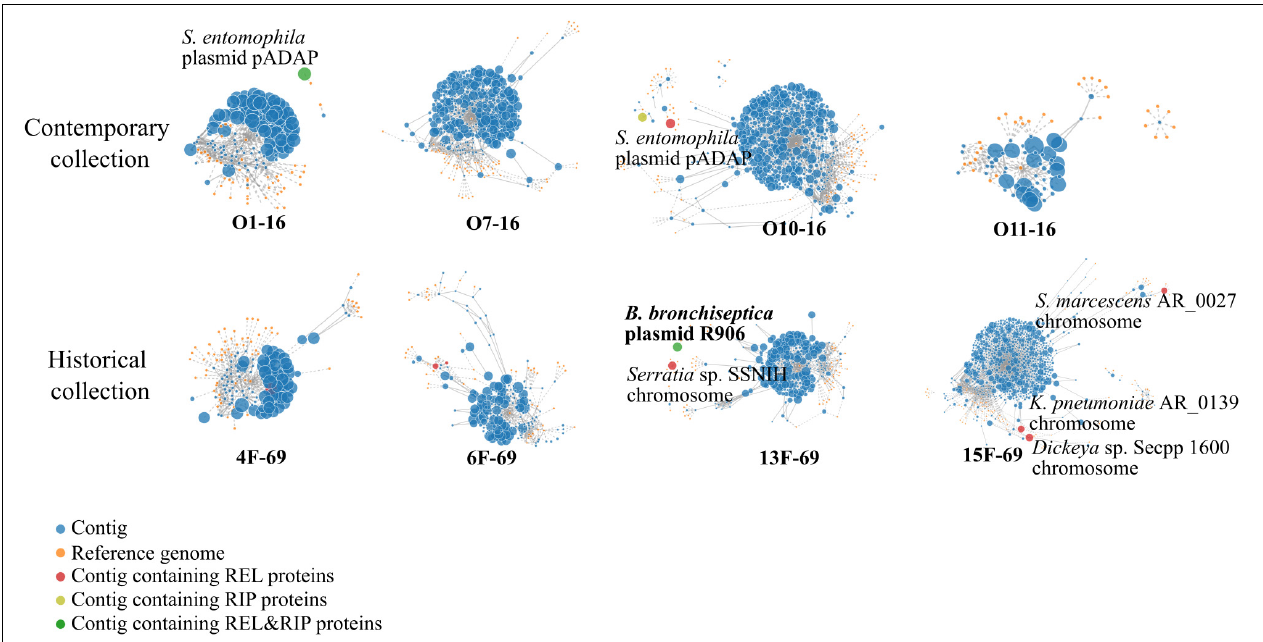
FIGURE 4 | PlacnetW output reflecting the plasmid sequences detected. All contigs from each genome are represented as blue nodes connected by continued lines. Yellow nodes represent reference genomes from the NCBI BLAST database. Discontinued lines link each contig to their closest reference genome/s. Finally, each genome appears represented by all its contigs displayed around their closest reference genome identity. Contigs containing plasmid sequences are highlighted in different colored nodes. REL, relaxase; RIP, replication initiation protein. TABLE 3 | Plasmid and prophage sequences annotated by PlacnetW and Phaster software, respectively. Isolate Plasmids and prophage sequences Similarity a Contigs b Size (bp) CDS